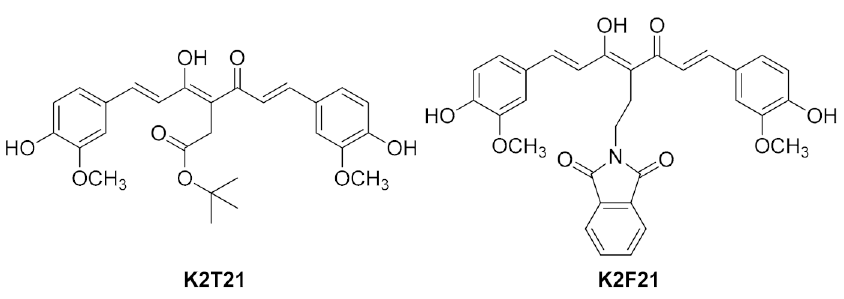
Figure 2. Structures of C4-substituted curcumin